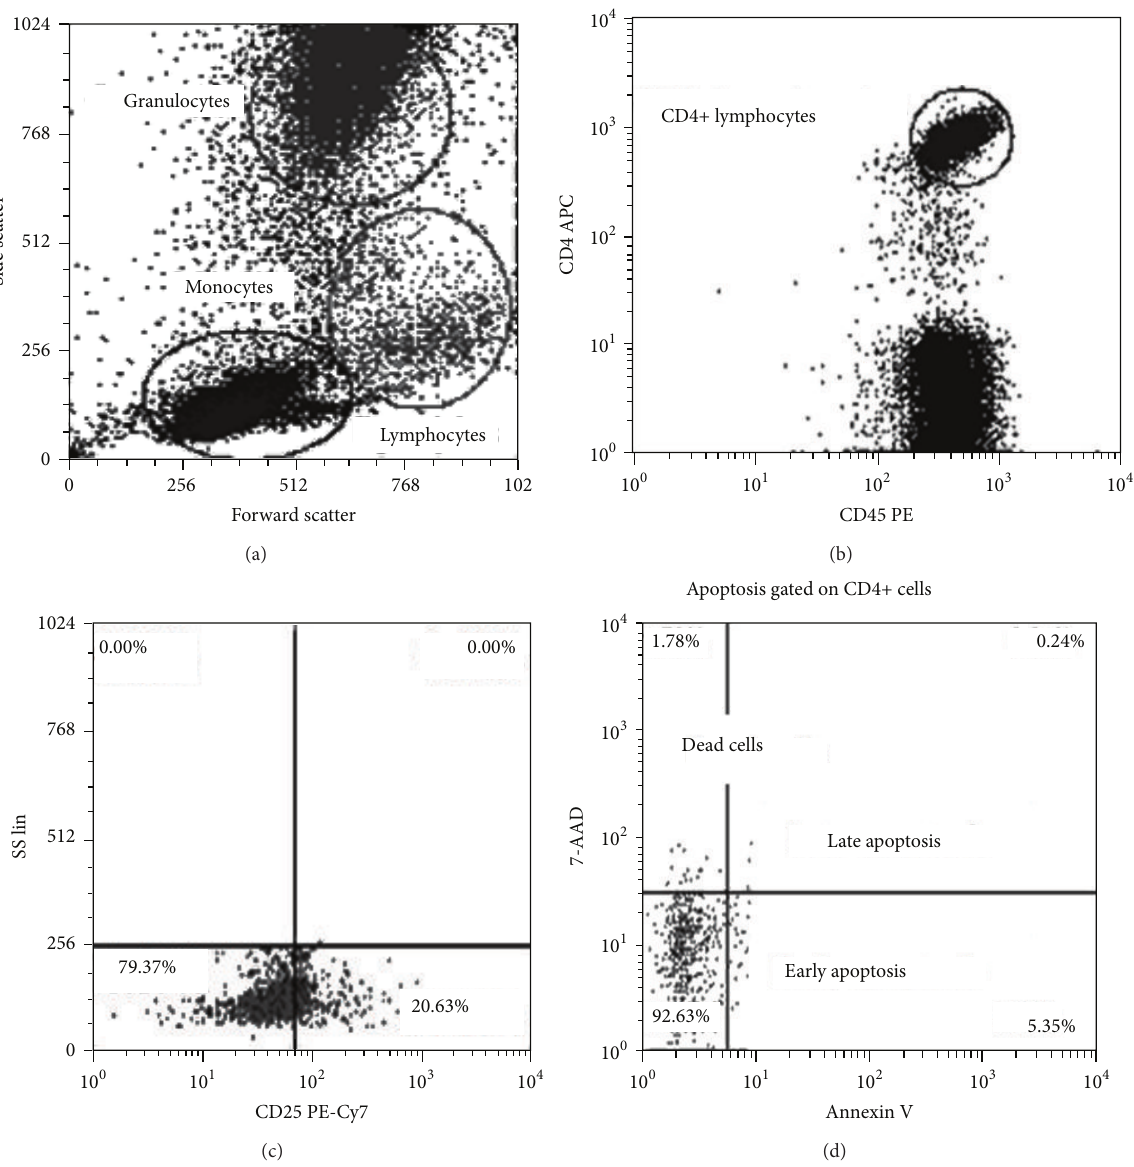
Figure 1: Gating strategy for activation (CD25) and apoptosis (annexin V/7-AAD). Plots (a) (side scatter versus forward scatter), (b) (bright CD4+ cells gated from the CD45+ leukocytes), (c) (CD25+ cells gated from the CD4 gate) and (d) (early, late apoptosis, and dead cells gated from CD4+ cells gate) show dot plots of whole blood used to set the quadrants. Table 2: The %CD25 expression before and after overnight stimulation with LPS and incubation with vitamin C and/or NAC. 𝑃 value for LPS activation and 𝑃 value between HIV %CD25 HIV+ group Controls inhibition by antioxidants in and control control